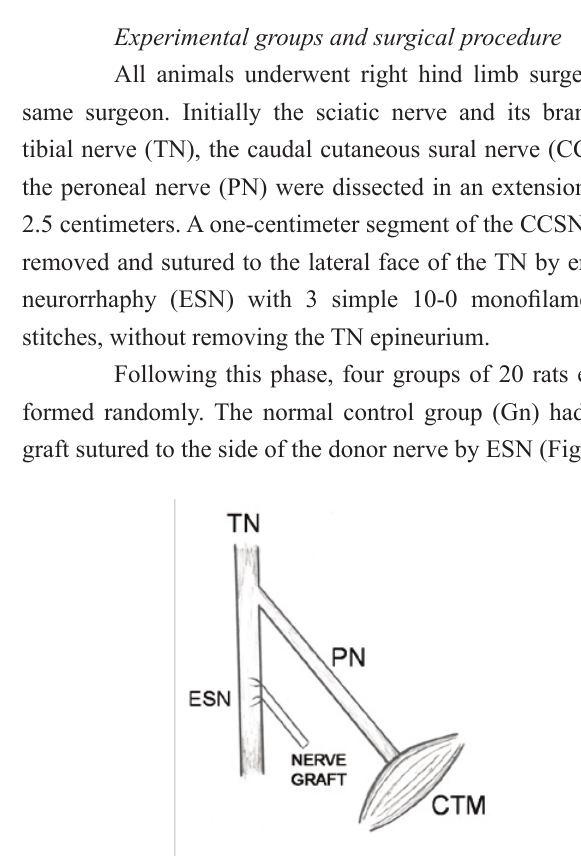
FIGURE 1 – Normal control group (Gn) and first surgery of G2 (two-stage). TN : tibial nerve. PN : peroneal nerve. ESN : end-to-side neurorrhaphy. CTM : cranial tibial